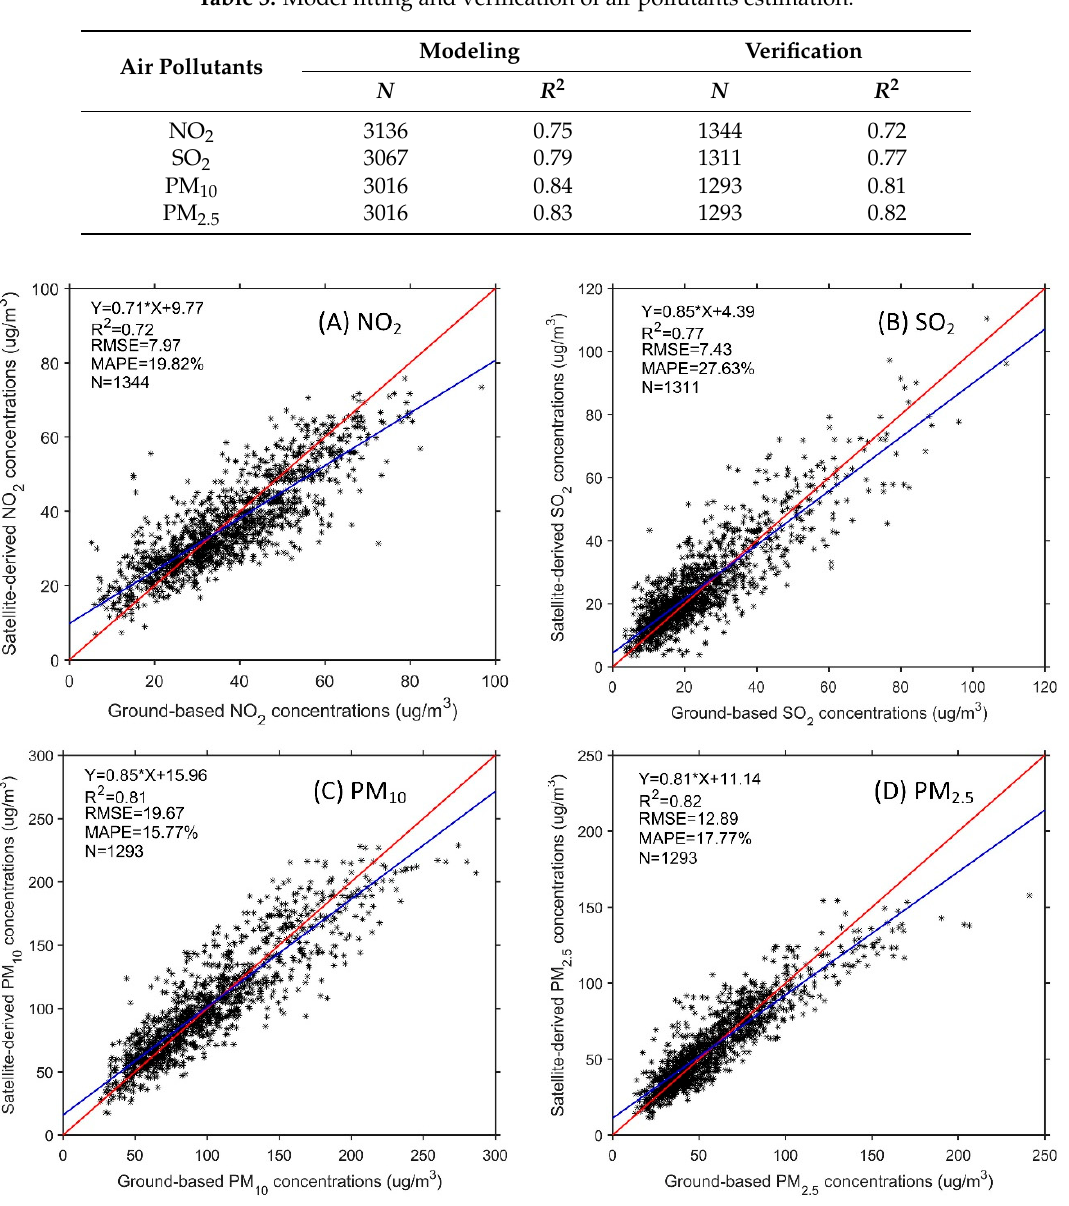
Figure 3. Comparison of satellite-derived air pollutant concentrations ( A ) NO 2 , ( B ) SO 2 , ( C ) PM 10 , ( D ) PM 2.5 with ground-based concentrations.